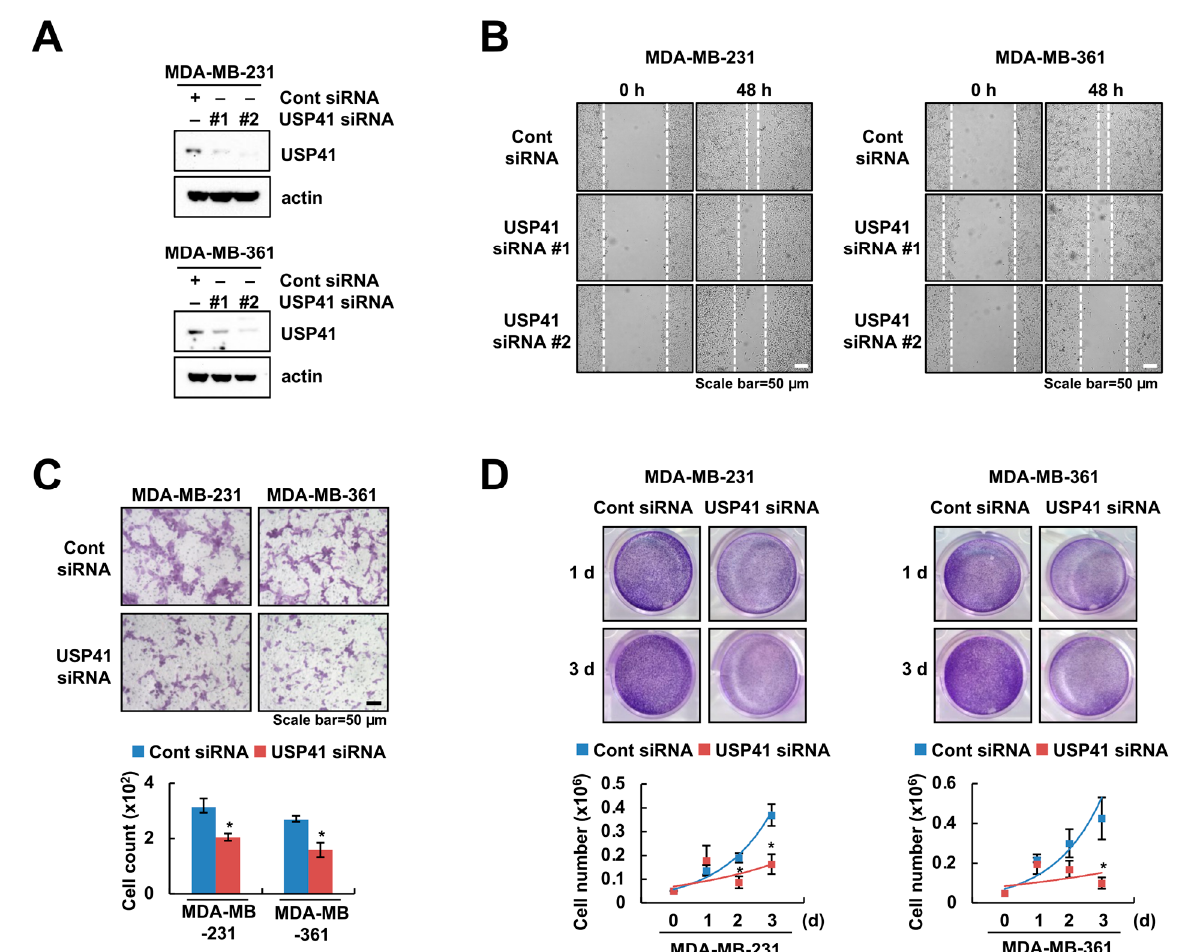
Figure 2. Knockdown of USP41 inhibits migration and proliferation of breast cancer cells. ( A – D ) MDA-MB-231 and MDA-MB-361 cells were transfected using control (Cont) and USP41 siRNA for 48 h. The protein levels of USP41 were examined by Western blotting ( A ). Migration ability was examined by wound healing assay ( B ) and transwell assay ( C ). Colony formation and cell growth were determined using crystal violet staining and cell counting, respectively ( D ). The values in the graph represent the mean ± SD of three independent samples, respectively. * p < 0.05 compared to the control siRNA.